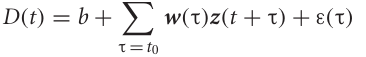
a short and long press and its ISI histograms for the same short (left) and long (right) (middle panel). The single trial ISI’s are compared, bin by bin, to templates generated from all remaining short and long duration presses (bottom panel). The template for which the comparison shows the minimum error between each single trial and each template is predicted classification result. If the predicted classification template indicated the correct press duration, then the trial was correctly classified (true